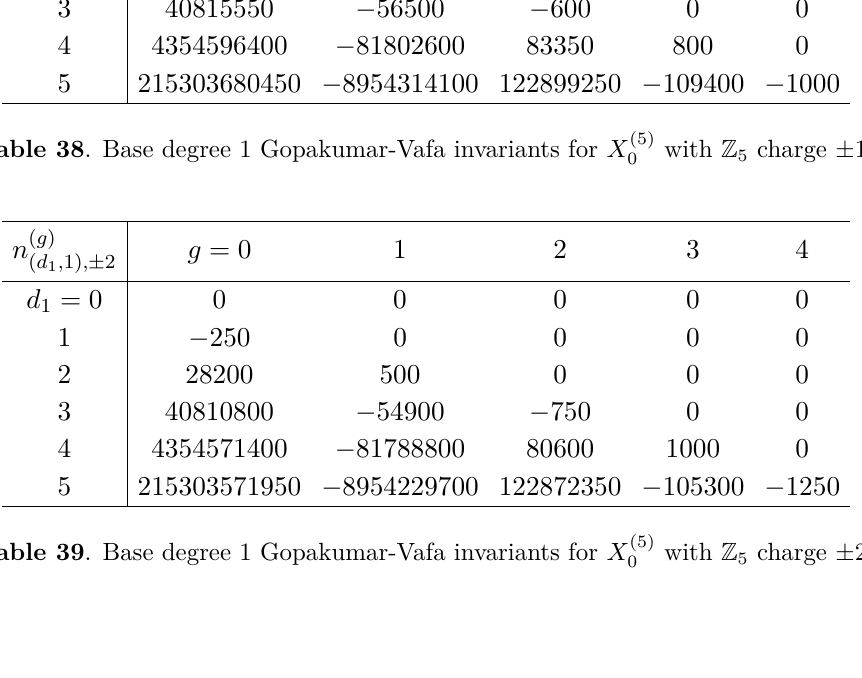
Table 38 . Base degree 1 Gopakumar-Vafa invariants for X (5)